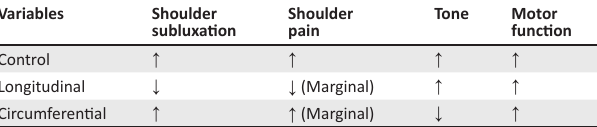
TABLE 7: Observed trends across the study period for increases ( ↑ ) or decreases ( ↓ ) in outcome measures for all